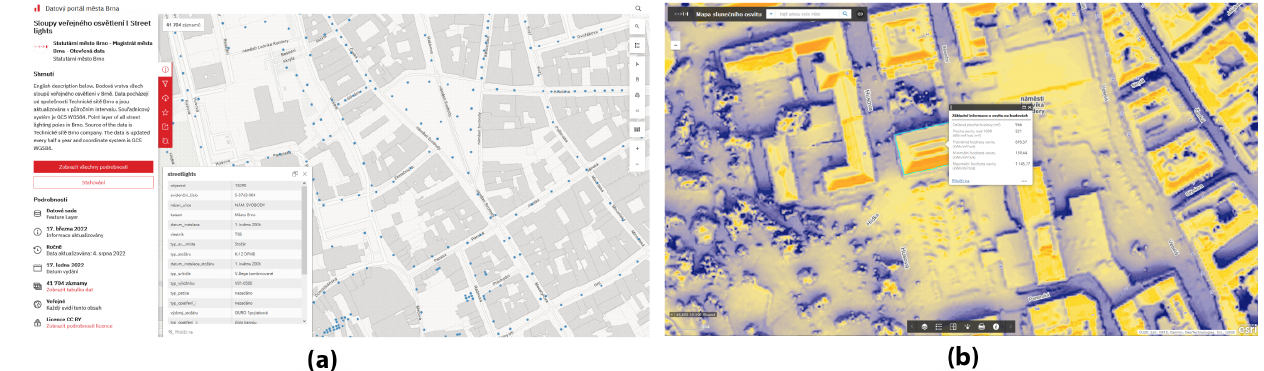
Figure 7. The data.Brno city data platform: ( a ) Dataset of public lighting with information about lamps. ( b ) The map of solar radiation intensity [29].